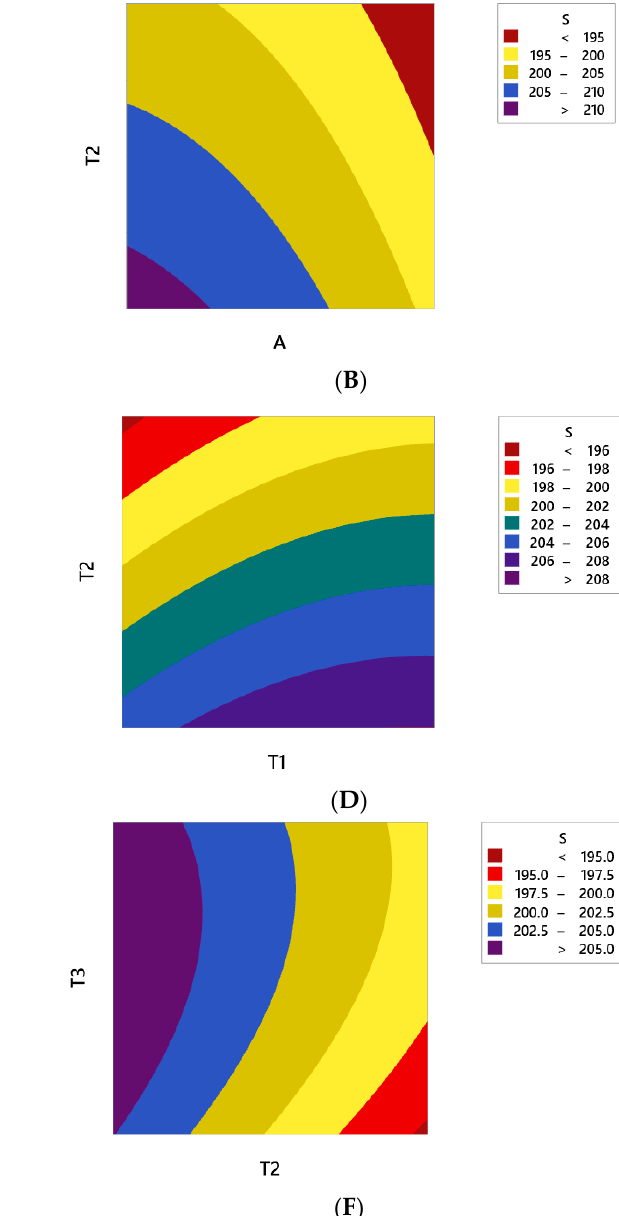
( D ) Figure 8. Maximum principal stress created in the critical area of the composite CNG tank in terms of various parameters including ( A ) variation of the fiber angle and the assumption T1 = 11 mm, T2 = 4.4 mm, and T3 = 3.3 mm, ( B ) variation of the wall-thickness of the top and bottom sections and the assumption that the fiber angle = 17, T2 = 4.4 mm, and T3 = 3.3 mm, ( C ) variation of the wall-thickness of the middle section and the assumption that the fiber angle = 17, T1 = 11 mm, and T3 = 3.3 mm, and ( D ) variation of the wall-thickness of the main section and the assumption that the fiber angle = 17, T1 = 11 mm, and T2 = 4.4 mm.